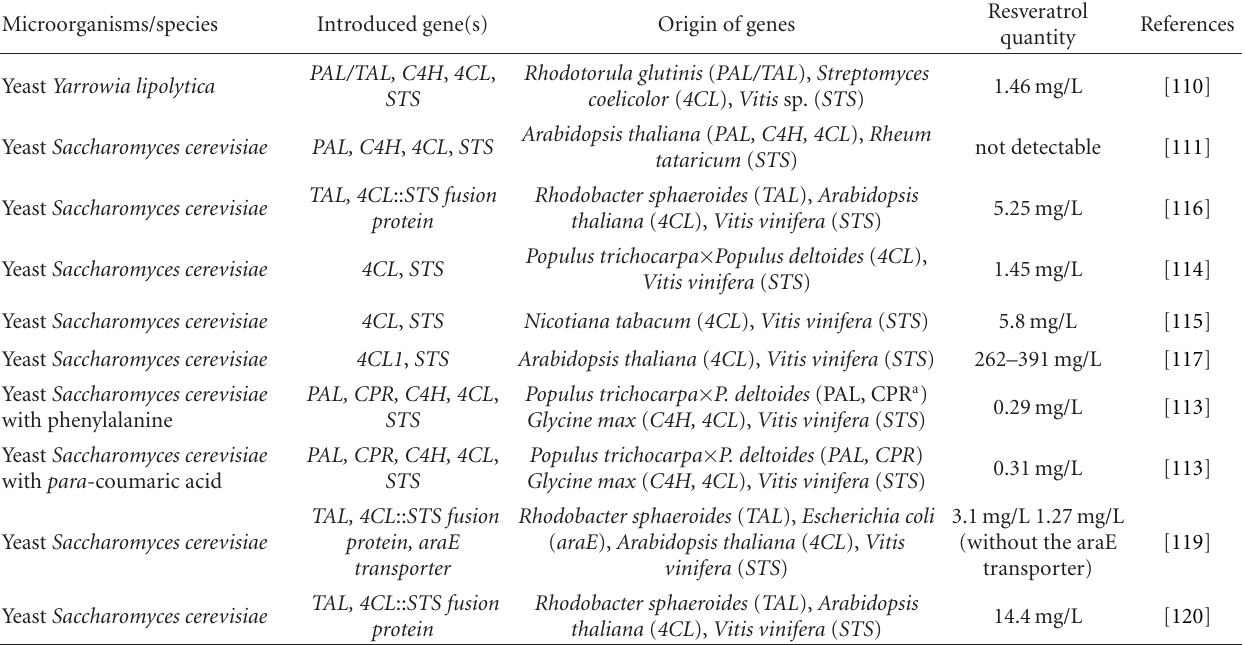
Table 1: Metabolic engineering of resveratrol in